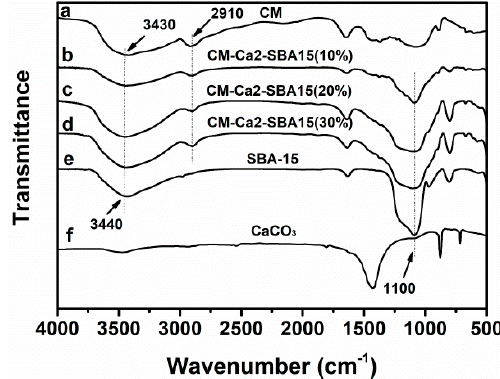
Figure 3. FTIR spectra of ( a ) CM, ( b ) CM-Ca2-SBA(10%), ( c ) CM-Ca2-SBA(20%), ( d ) CM-Ca2-SBA(30%), ( e ) SBA-15 and ( f ) CaCO 3.